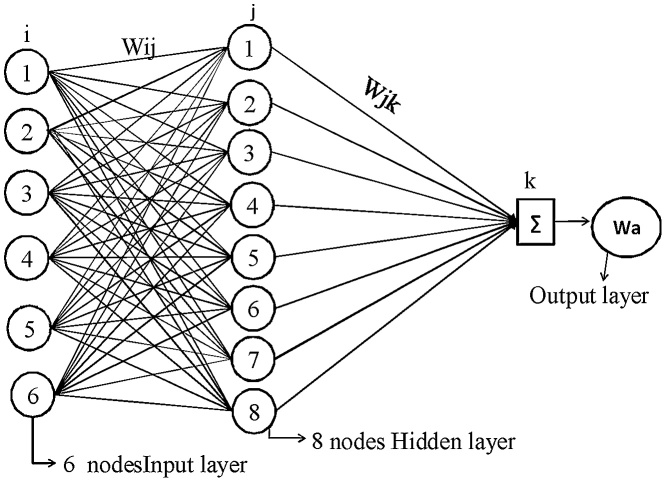
BP-ANN model for Wa.